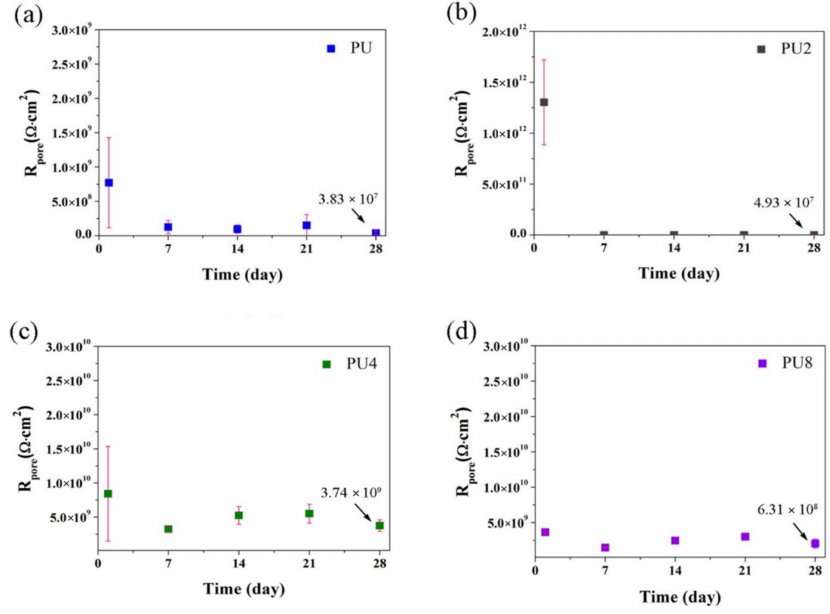
Figure 4. Evolution of R pore of various coating samples during 28 days of immersion in 3.5 wt.% NaCl solution: ( a ) PU, ( b ) PU2, ( c ) PU4 and ( d )